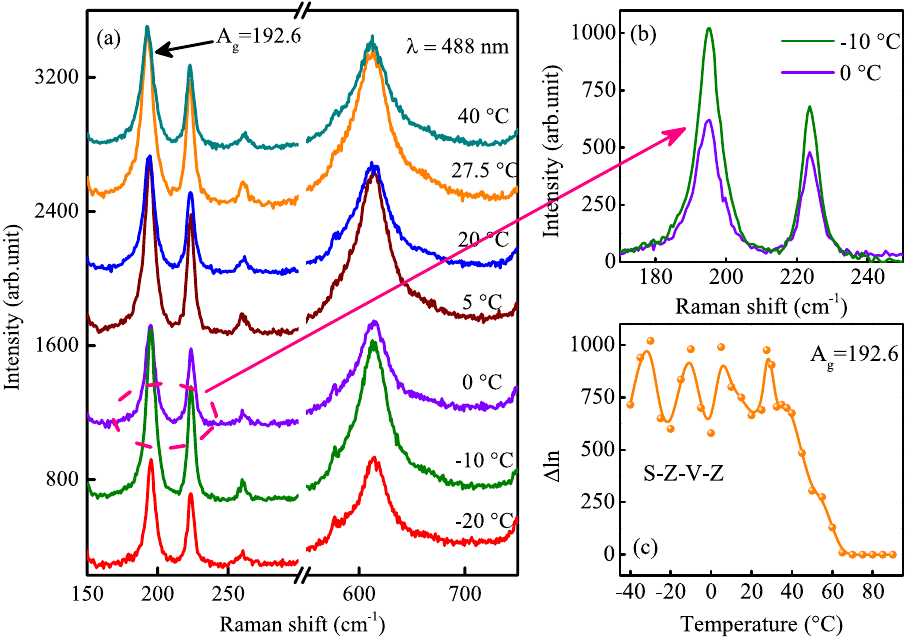
Figure 7. ( a ) The low temperature Raman spectra of the S-Z-V-Z structure, the wavelength of exciting light was 488 nm. ( b ) The enlarged picture of the Raman spectra with temperature of − 10 °C and 0 °C, which was labeled by the pink dashed circle in ( a ). ( c ) The temperature dependent Raman intensity from low temperature to high temperature.